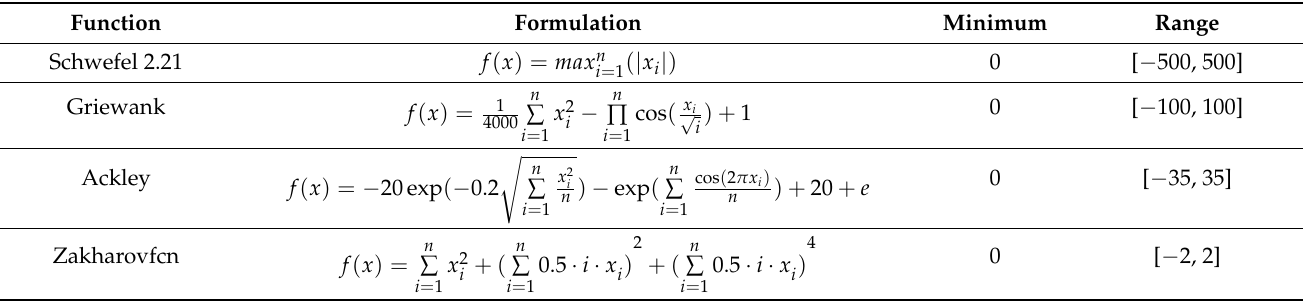
Table 6. Benchmark function details.